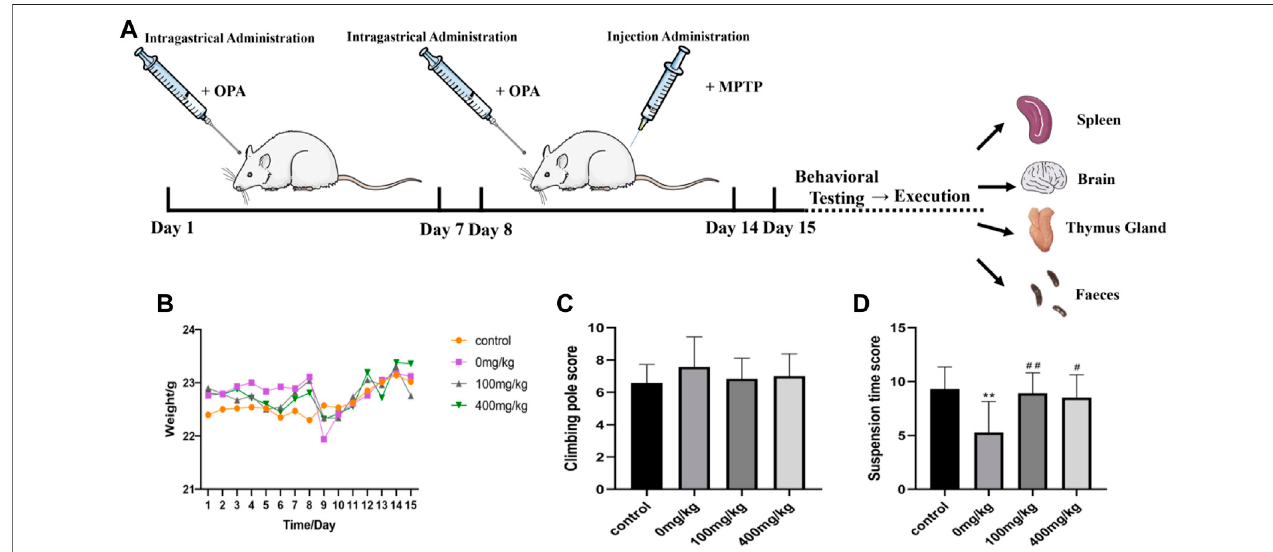
FIGURE 3 | Effects of OPA on weight and behavior of MPTP-induced PD model mice. (A) the scheme of experimental procedures. (B) the change of body weight during14 days( n =10,mean±SD); (C) TheresultsofPDmodelmiceinclimbingrodtest( n =10,mean±SD); (D) thedifferenceofPDmodelmiceinsuspensiontest( n = 10, mean ± SD). ** p < 0.01 compared with control mice injected with saline; # p < 0.05, ## p < 0.01 compared with MPTP-treated